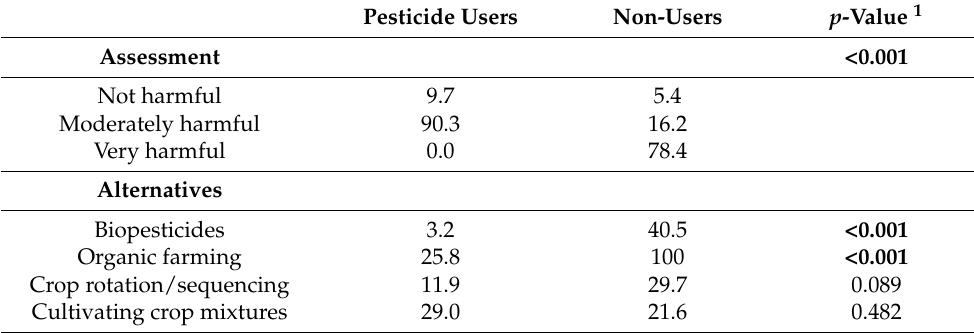
Table 4. Knowledge and perceptions about pesticides (in